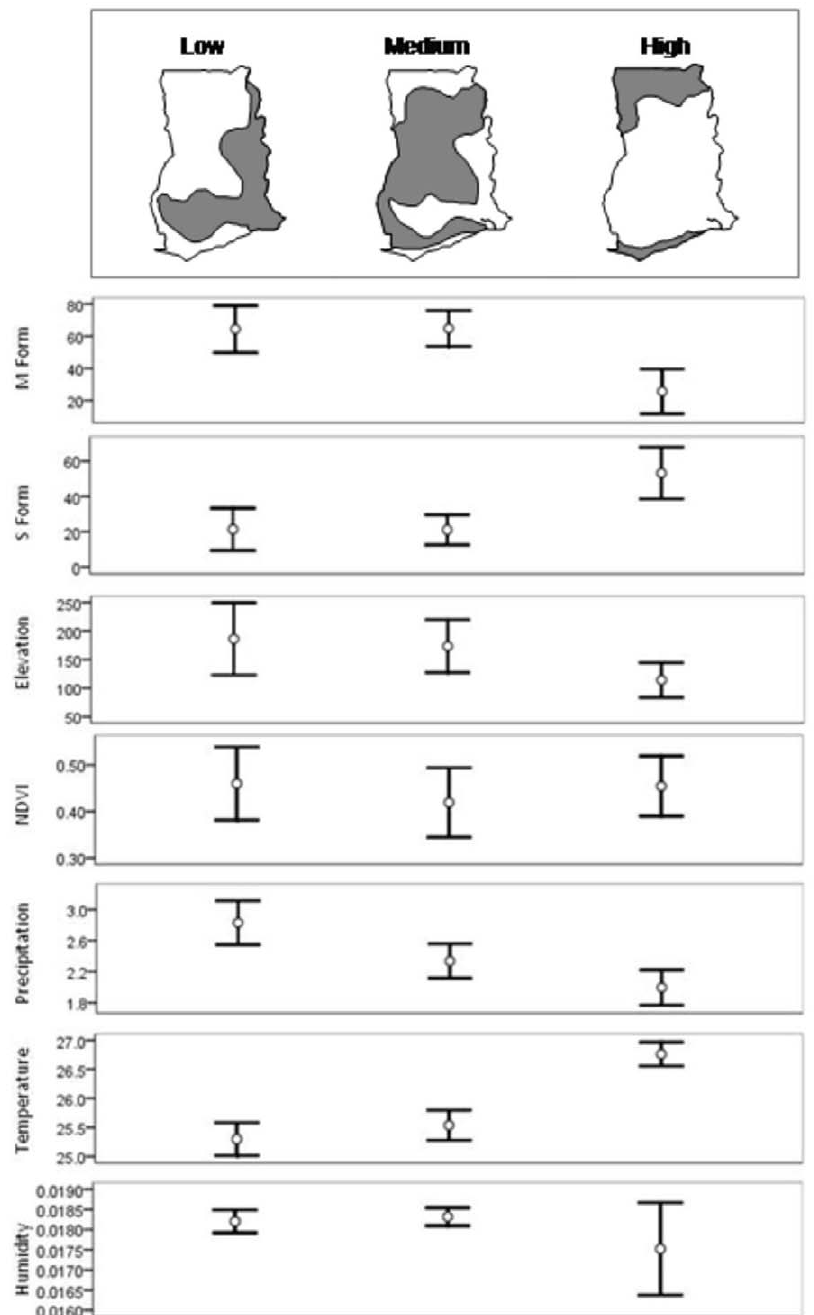
Figure 5. Summary of entomological and environmental variables in different LF transmission zones. Note: The maps represent the LF transmission zones in Ghana. The graphs below summarize the mean entomological and environmental measures for the sites within each zone. NDVI stands for Normalized Difference Vegetation Index.